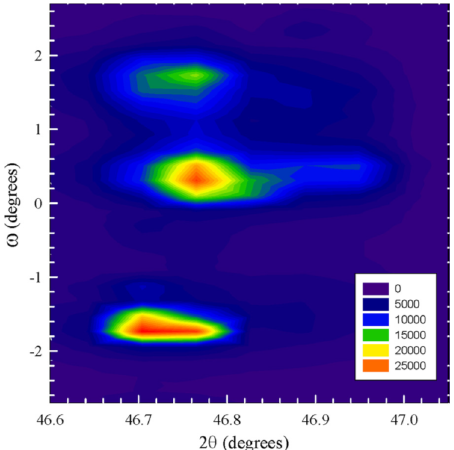
Figure 11. (002)c XRD reciprocal space mapping. The mapping intensity is on a log scale. Reproduced with permission from [55].